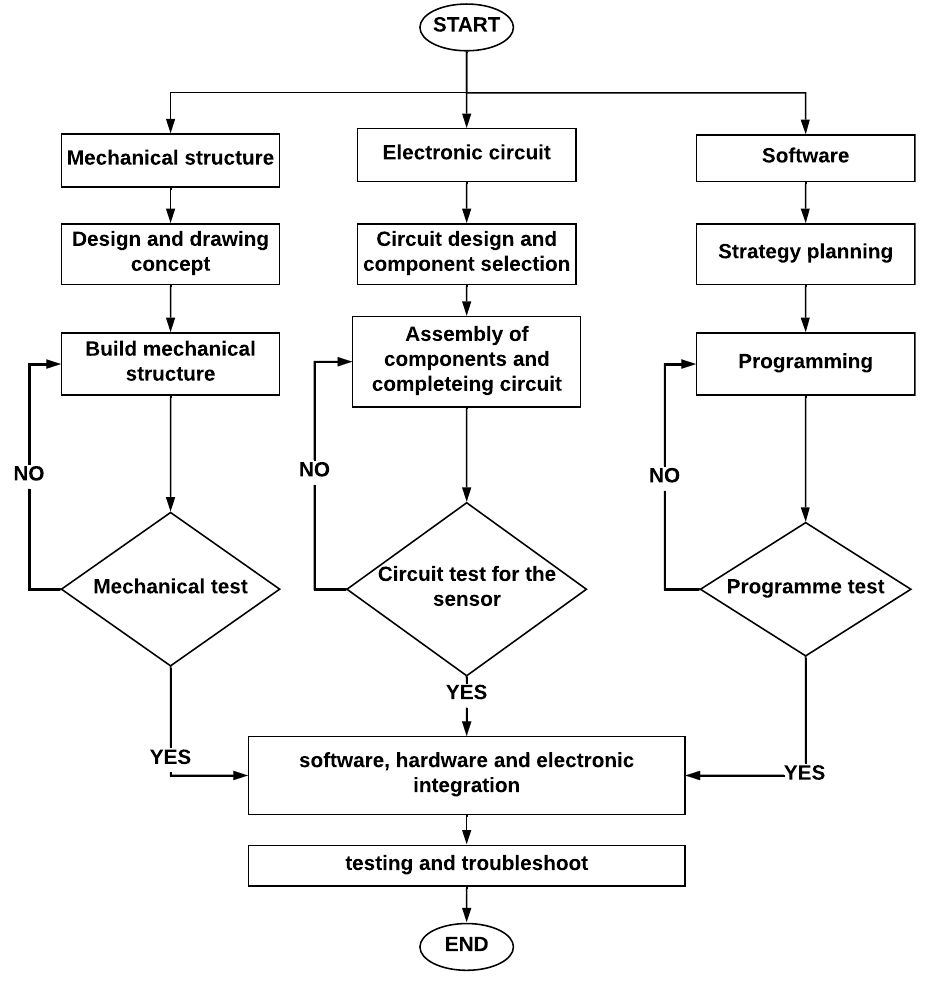
Figure 7. Flow chart of the complete robotic